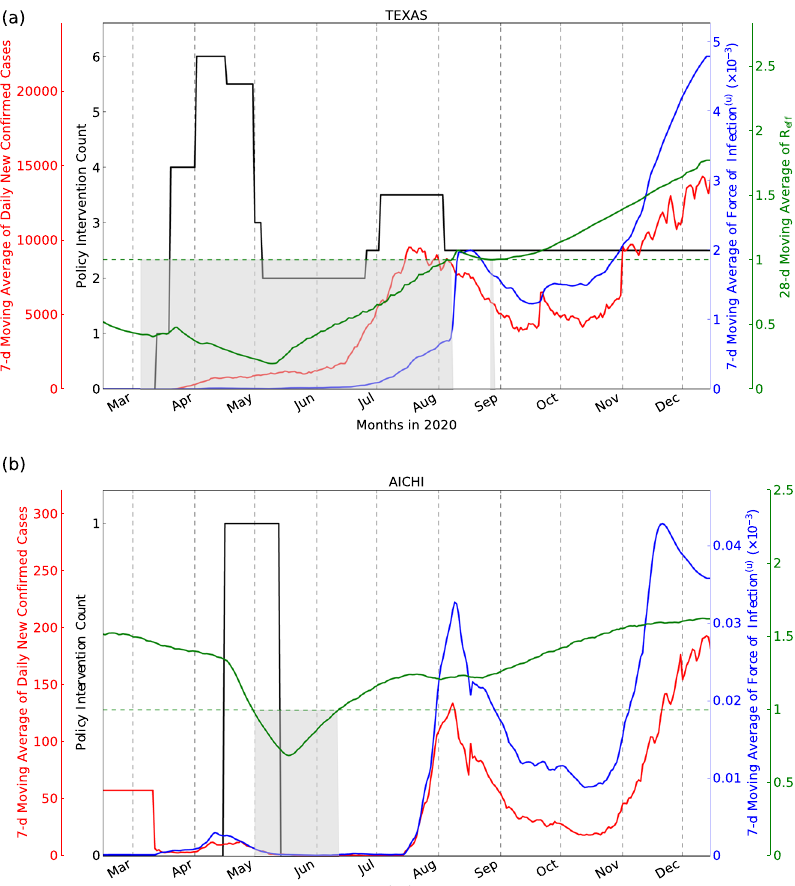
Fig. 6 Model outputs. New daily con fi rmed cases, number of NPIs, F ( u ) and R eff for Texas, USA ( a ) and Aichi, Japan ( b ), chosen to represent a location with high and low COVID-19 associated deaths, respectively. Seven-day moving average of the daily con fi rmed case counts and number of Non-Pharmaceutical Interventions (NPIs) are plotted on the left y axis, and the 7-day moving average of F ( u ) (see Eq. (11)) and the 28-day moving average of R eff (see Eq. (13)) are plotted on the right y axis. For R eff < 1 (shaded gray regions below the horizontal dotted line), dynamics are tending toward the Disease-Free Equilibrium (DFE) 118 . These areas often overlap with the dates when multiple NPIs are